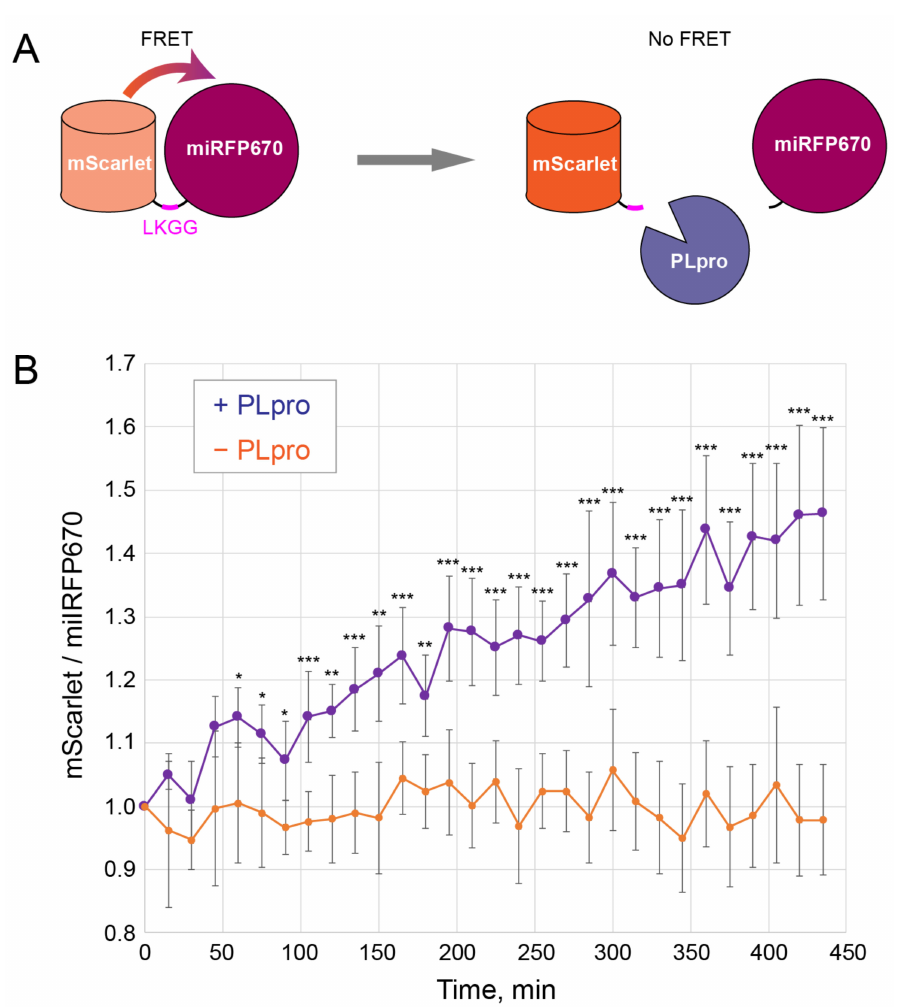
Figure 2. FRET sensor of PLpro activity. ( A ) Scheme of the sensor consisting of the FRET donor mScarlet and acceptor miRFP670 fluorescent proteins connected by the linker with LKGG recognition site for PLpro. PLpro cleaves the linker and thus eliminates FRET, leading to the increase in mScarlet fluorescence intensity. ( B ) Changes in the mScarlet/miRFP670 fluorescence ratio in cells during time-lapse microscopy upon induction of PLpro expression (purple) or without PLpro (orange). Mean and standard deviation for 15 cells in 3 independent experiments for each curve are shown. *, **, ***: p -values less than 0.05, 0.01, and 0.001, respectively ( t